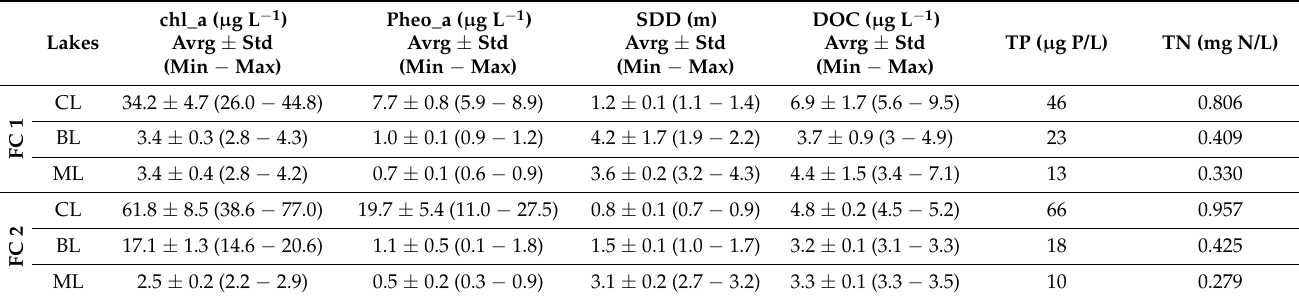
Figure 4. Classes of lake trophic levels with corresponding values of total phosphorus. Chlorophyll-a and water transparency. Inspired from the environmental Ministry of Quebec website (http://www.environnement.gouv.qc.ca/eau/rsvl/methodes.htm, accessed on 4 February 2021). Table 1. A summary of water properties analyzed (chlorophyll-a (chl_a), pheophytin-a (Pheo_a), Secchi disk depth (SDD)), dissolved organic carbon (DOC), total phosphorous (TP), and total nitrogen (TN). FC1 and FC2 refer to field campaigns 1 and 2, respectively. Avrg, Std, Min, and Max refer to average, standard deviation, minimum, and maximum values, respectively. CL, BL, and ML refer to Champlain, Brome, and Magog Lakes.